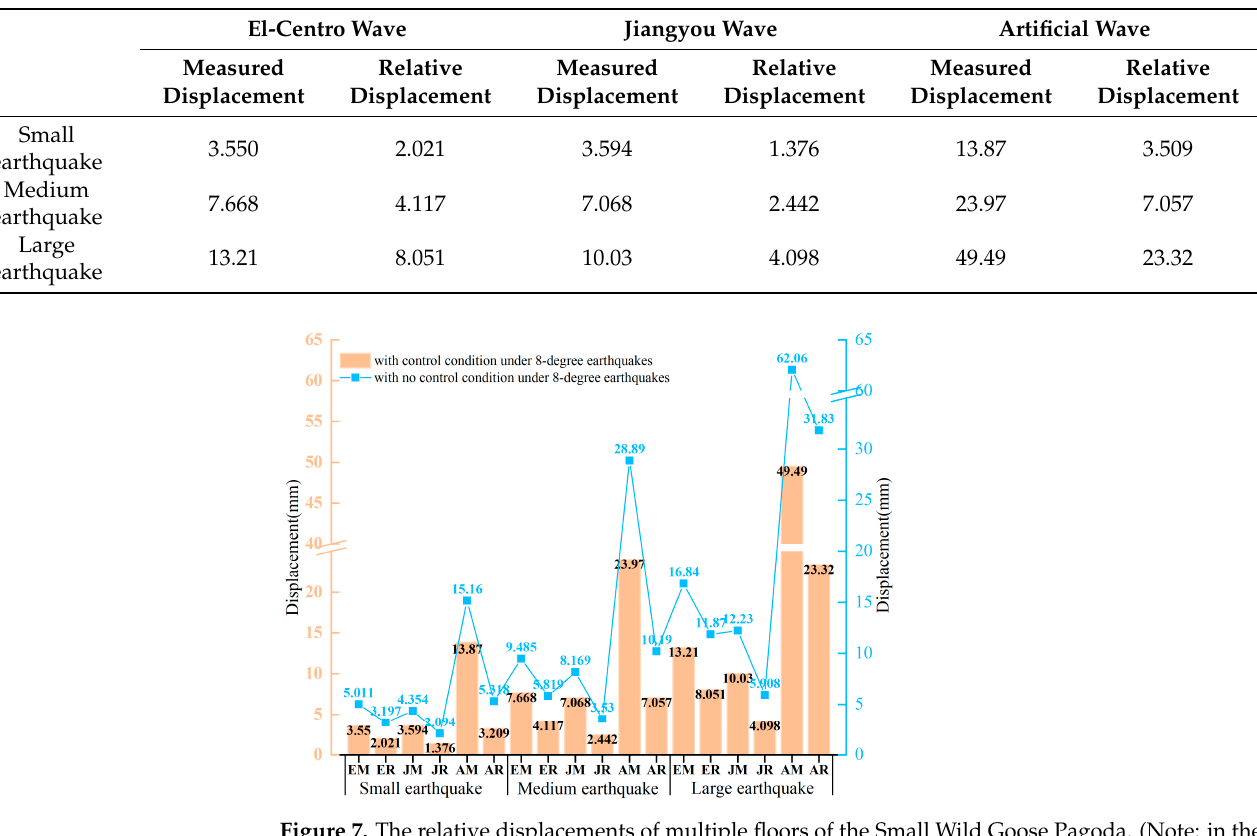
Table 6. The maximum relative displacement of the top floor of the tower with control condition under 8-degree earthquakes (mm).